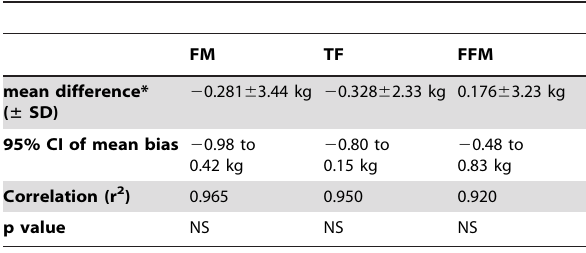
Table 5. Body composition of the Cross Validation group is predicted by the regression equations derived from the Index